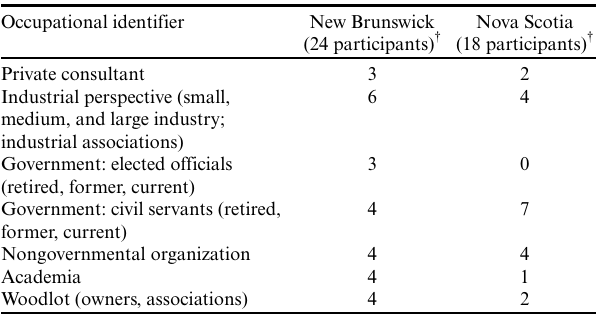
Table 1. List of interview participants’ occupational